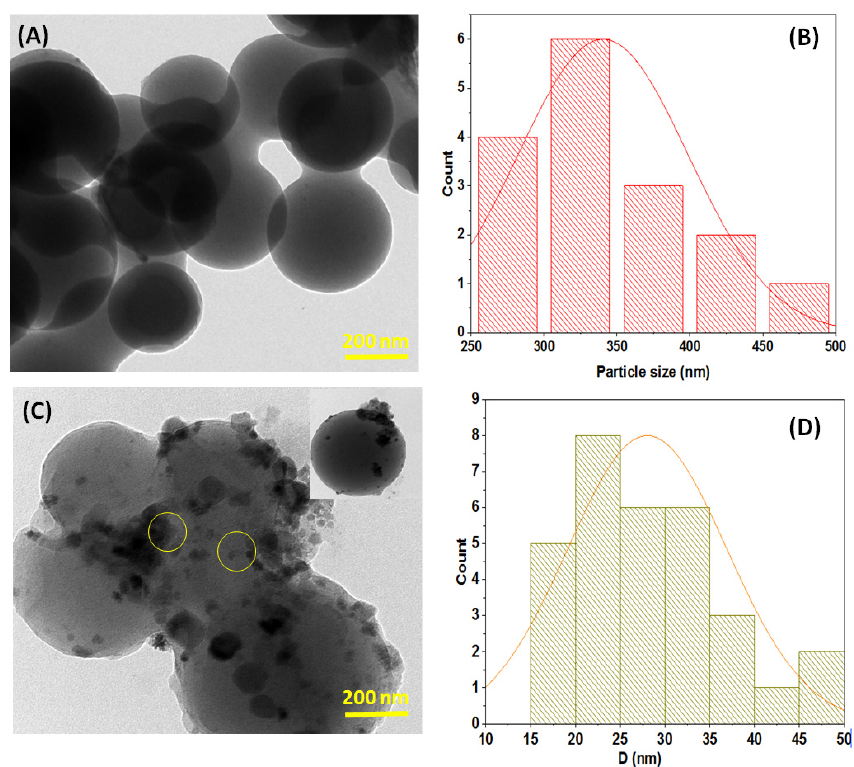
Figure 3. HRTEM and particle size distribution histogram of CSs ( A , B ) and Ni@CS composites ( C , D ).